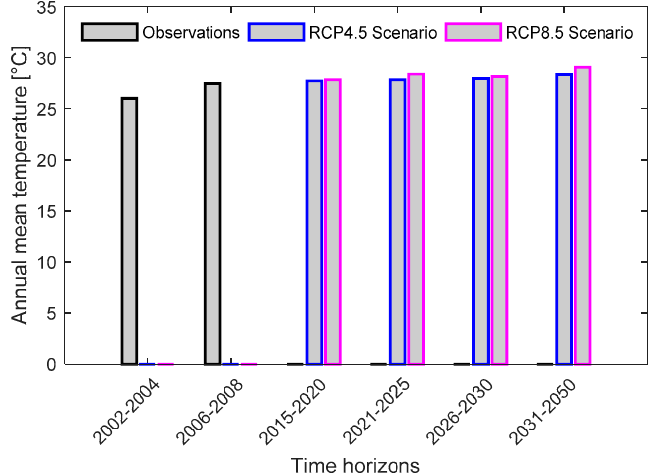
Figure 3. Observed temperature and REMO corrected temperature scenarios.